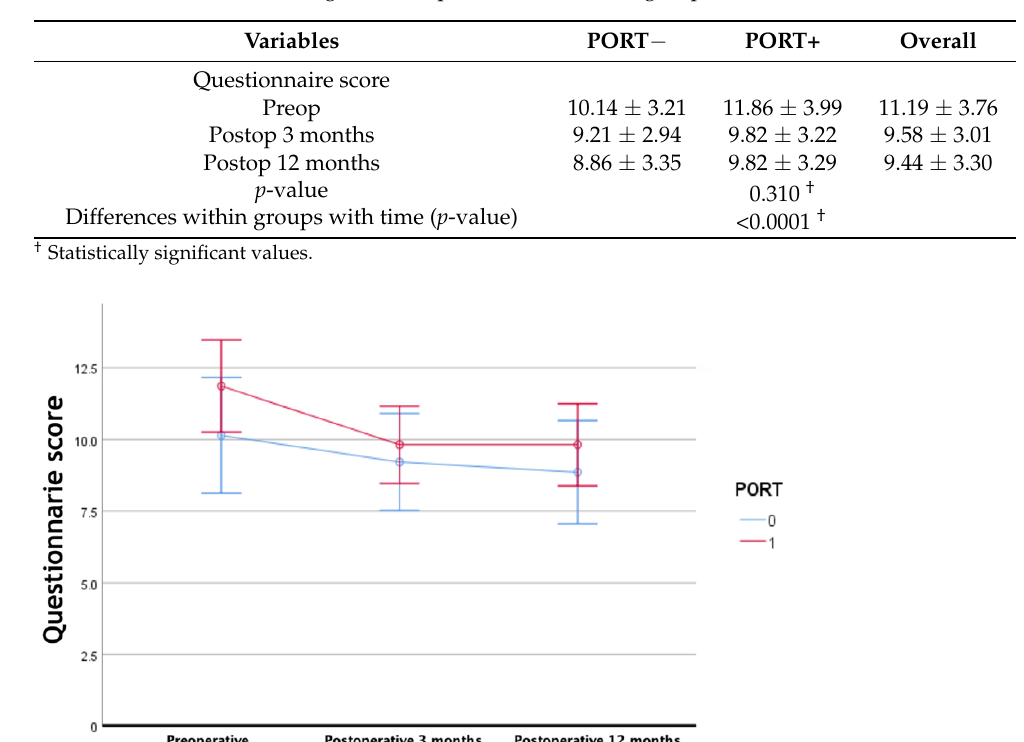
Table 5. Questionnaire findings and comparison between the groups.